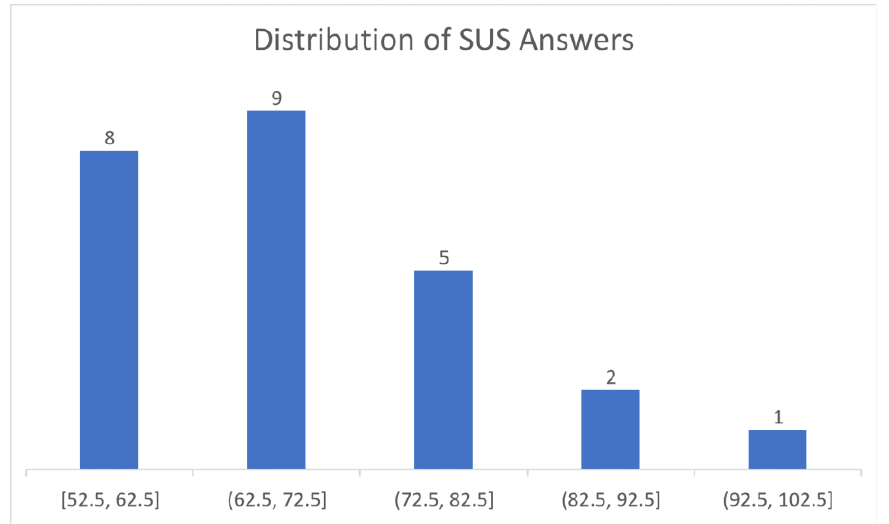
Figure 17. Distribution of SUS Answers.